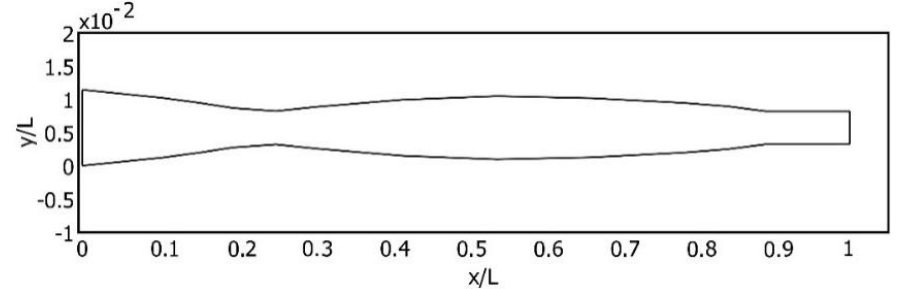
Figure 2. Normalized shape of the optimally-shaped cantilever.